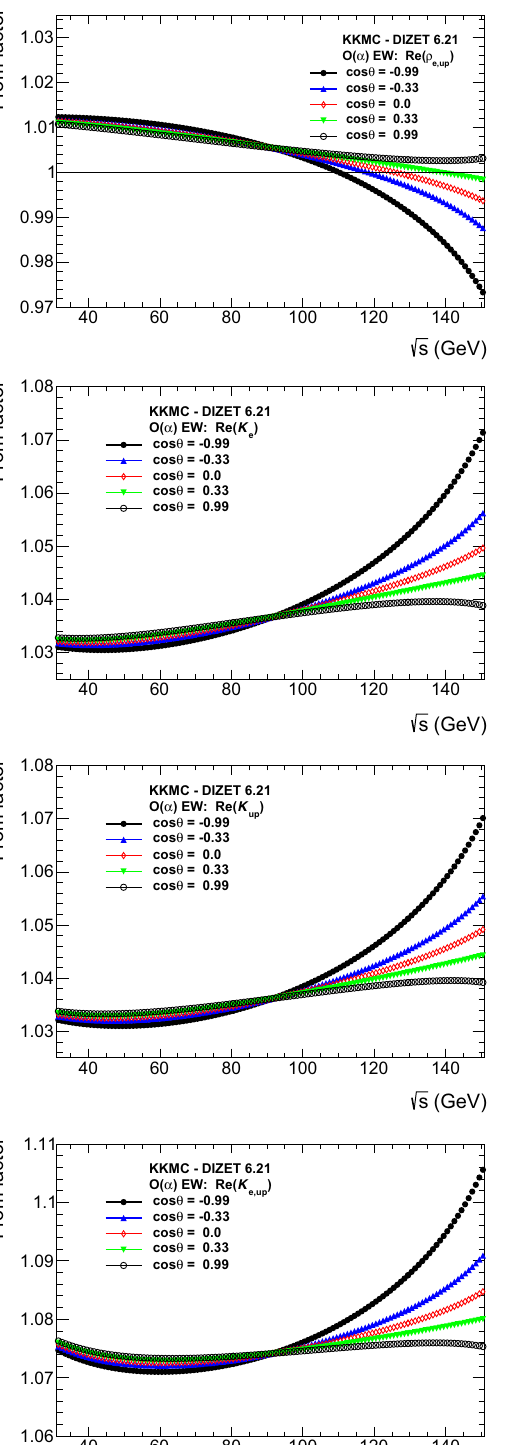
√ s and for the few values of